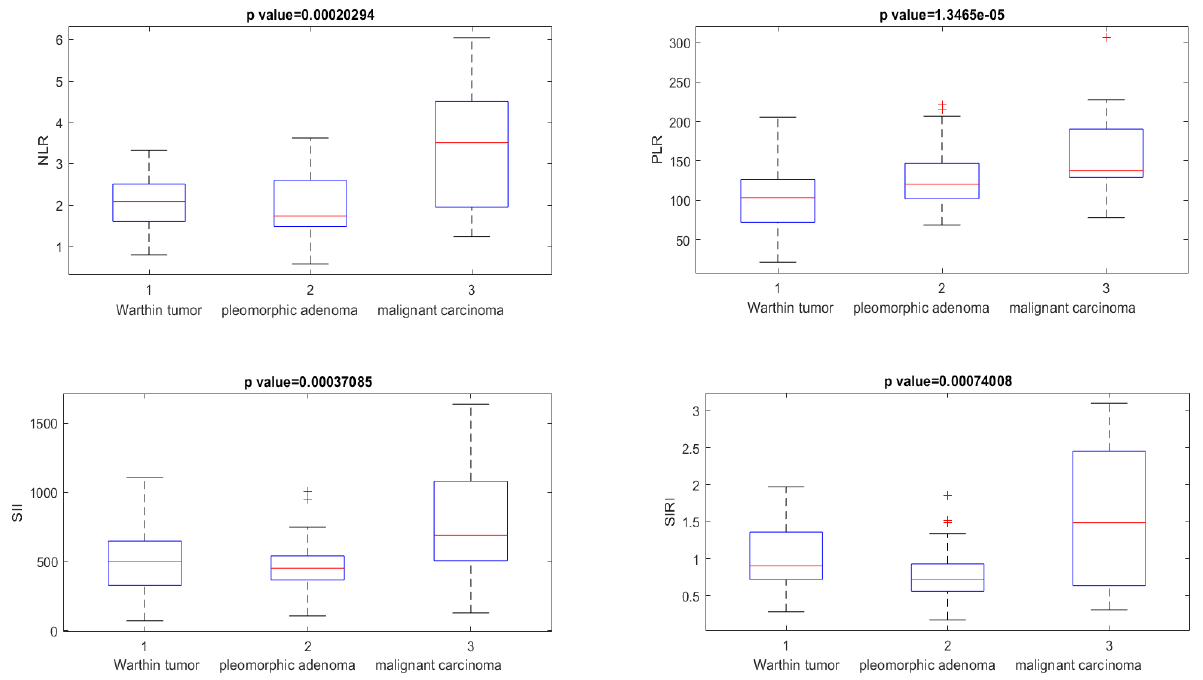
Figure 2. Main histopathological types of the malignant population studied.